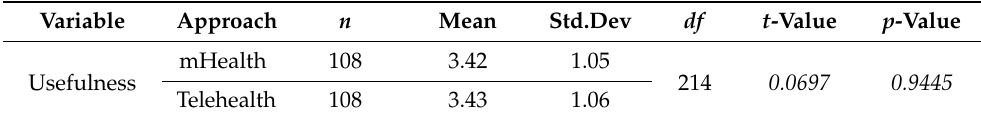
Table 7. Difference in interface quality of mHealth and Telehealth.